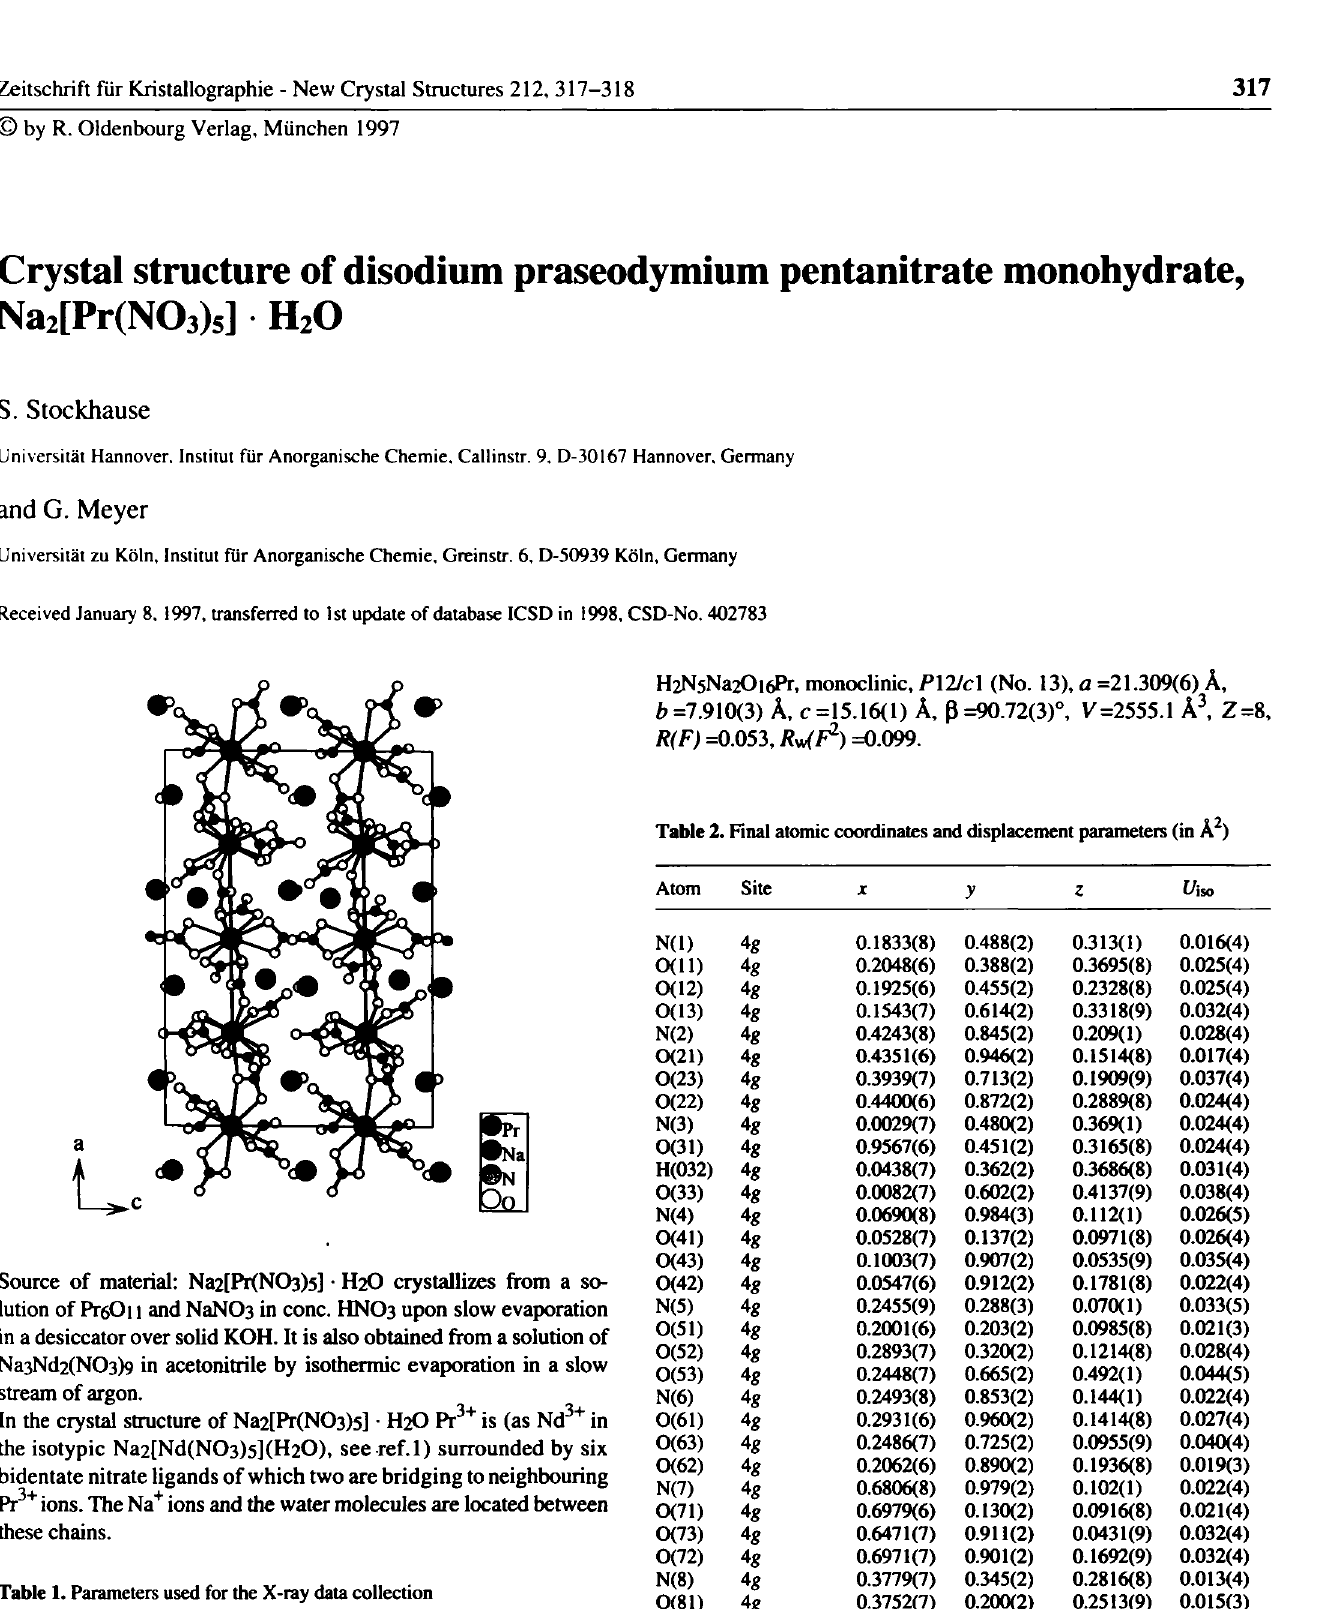
Table 1. Parameters used for the X-ray data collection Crystal: